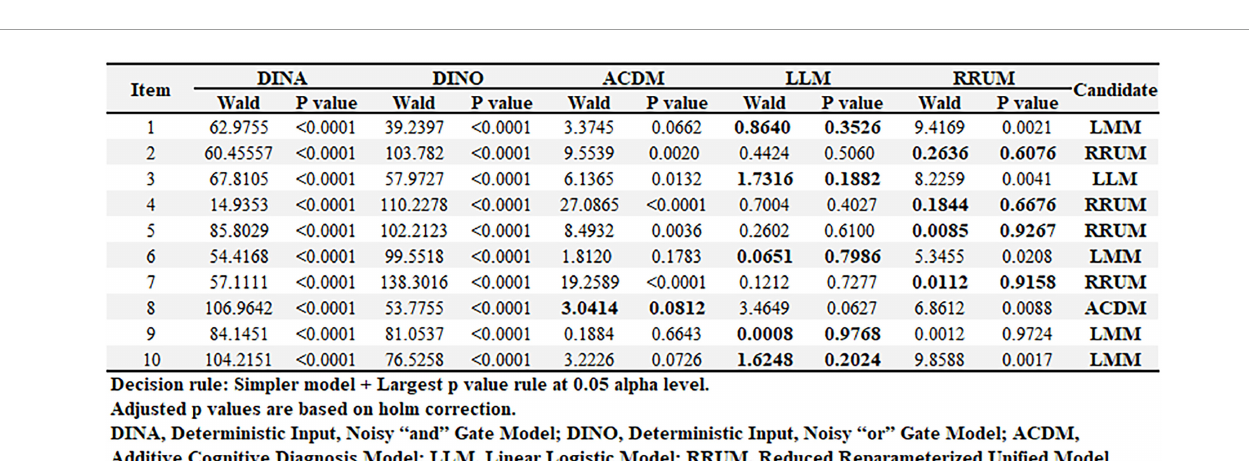
FIGURE5 Item-level model